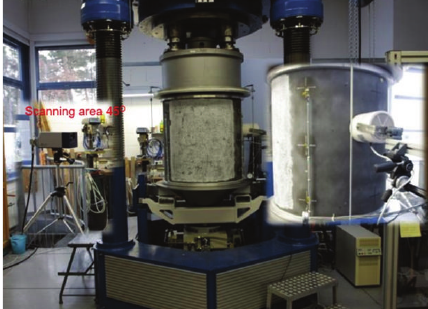
Figure 6: Experimental test setup for compressive loading on Z37 cylindrical shell (DLR).